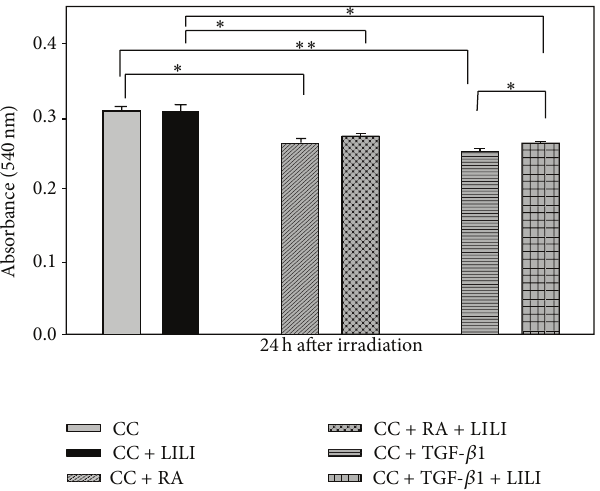
Figure 1: Cellular proliferation as assessed by optical density at 24 h after irradiation. Groups that were irradiated increased in proliferation as compared to those that were not exposed to irradiation. A decrease in proliferation was observed in groups that had growth factors as compared to those without growth factors.